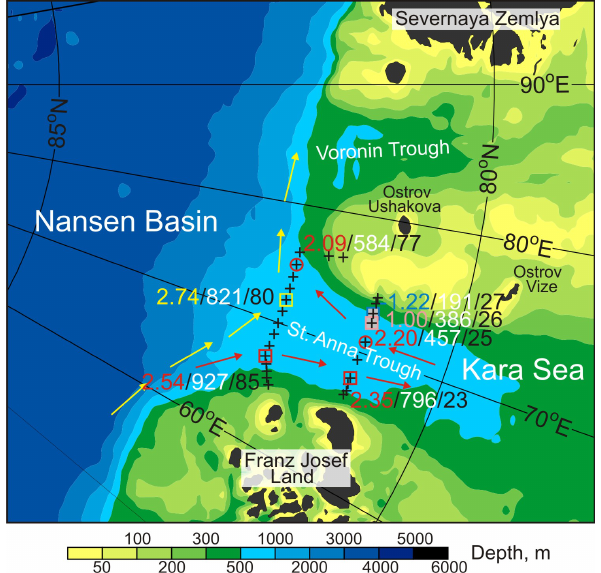
Figure 2. Map of the northern Kara Sea showing the St. Anna Trough (ST). Arrows show the Fram Strait branch of the AW in- flow into the Arctic Ocean, which recirculates in the ST (red ar- rows, SFSBW) and follows the continental margin (yellow arrows, FSBW). Crosses depict the positions of CTD stations taken in September 2009 at two sections crossing the ST at ∼ 81 and 82 ◦ N. Red squares and circles identify stations taken through the core of the SFSBW inflow and outflow to/from the ST, respectively. The yellow square identifies a station taken through the core of the FSBW boundary current. The pink square depicts the mooring posi- tion. The pink and blue squares with gray shading identify stations used for estimates of uncertainty in the vertical heat flux due to spatial undersampling of the AW jet. The first (yellow/red) num- ber shows the FSBW/SFSBW core temperature (in ◦ C) in Septem- ber 2009. The first pink and blue numbers show temperature at 110m. The second (white) number is heat content (in MJm − 2 ) computed relative to the freezing temperature between 30 to 90m depth. The third (black) number denotes the station